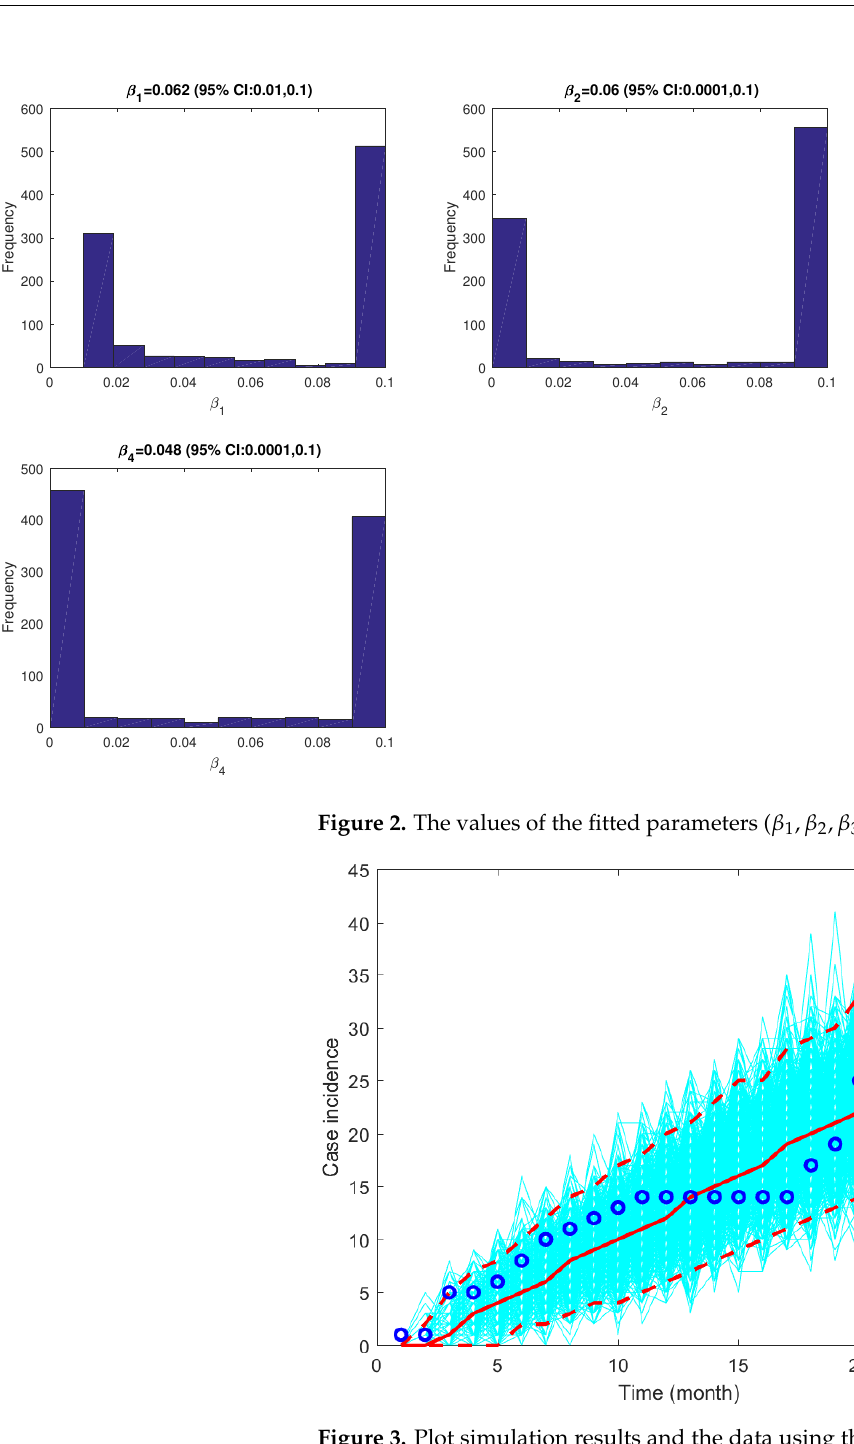
Figure 3. Plot simulation results and the data using the fitted parameter values based on monthly data from Wee Luri Health Center, Sumba,